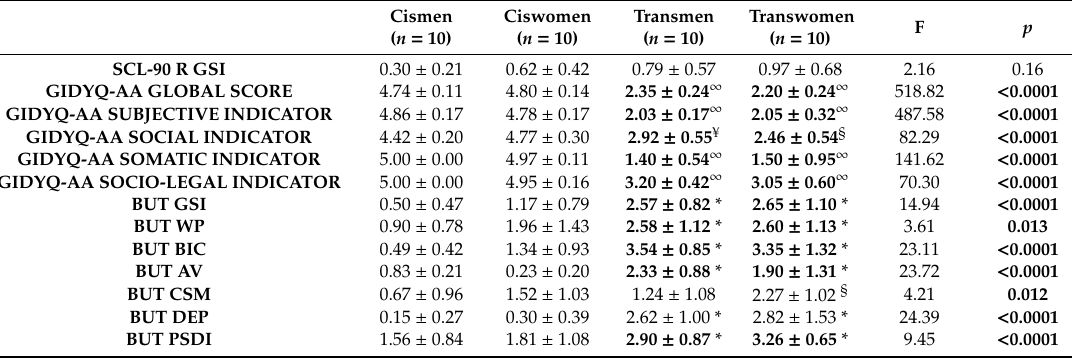
Table 4. Summary of means, standard deviations and statistical di ff erences in terms of general psychopathology (SCL-90R), gender dysphoria levels (GIDYQ-AA) and body uneasiness (BUT) between Cismen, Ciswomen, Transmen and Transwomen, as derived by ANCOVA and Post-hoc Tukey B test after adjustment for Age and